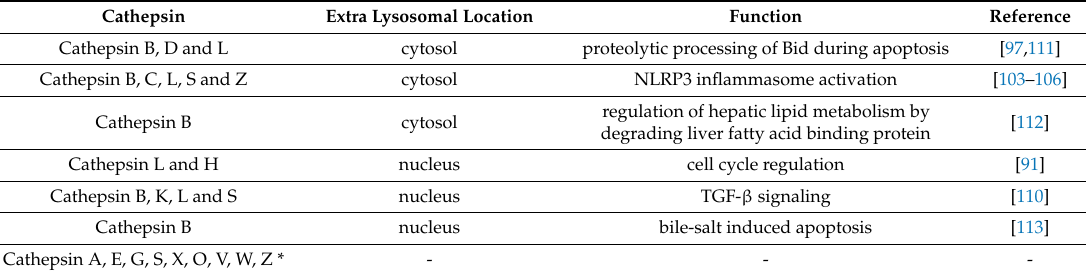
Table 2. Function of cathepsins in the